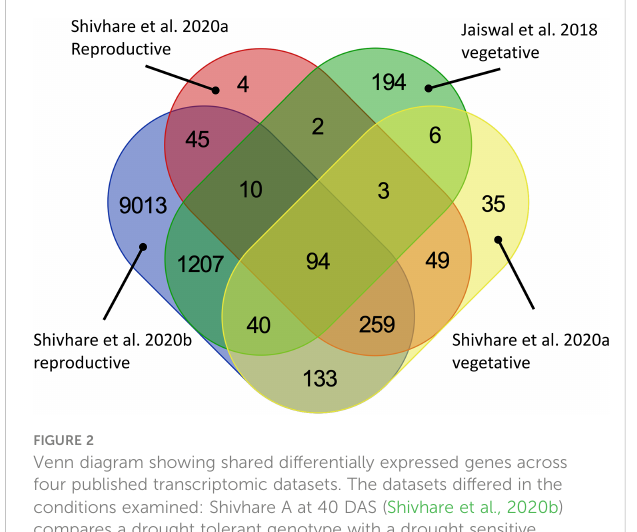
FIGURE 3 Biological process related gene ontology (GO) enrichment analysis of the 94 genes common to all studies that were compared, presented in a multidimensional scaling-based visualization from REVIGO. Out of 28 main GO terms, the GO terms with semantic similarities (genes having similar ontology are compared based on degree of relatedness by the similarity in meaning of their annotations) have clustered together. Clusters are represented by most signi fi cant GO term found by